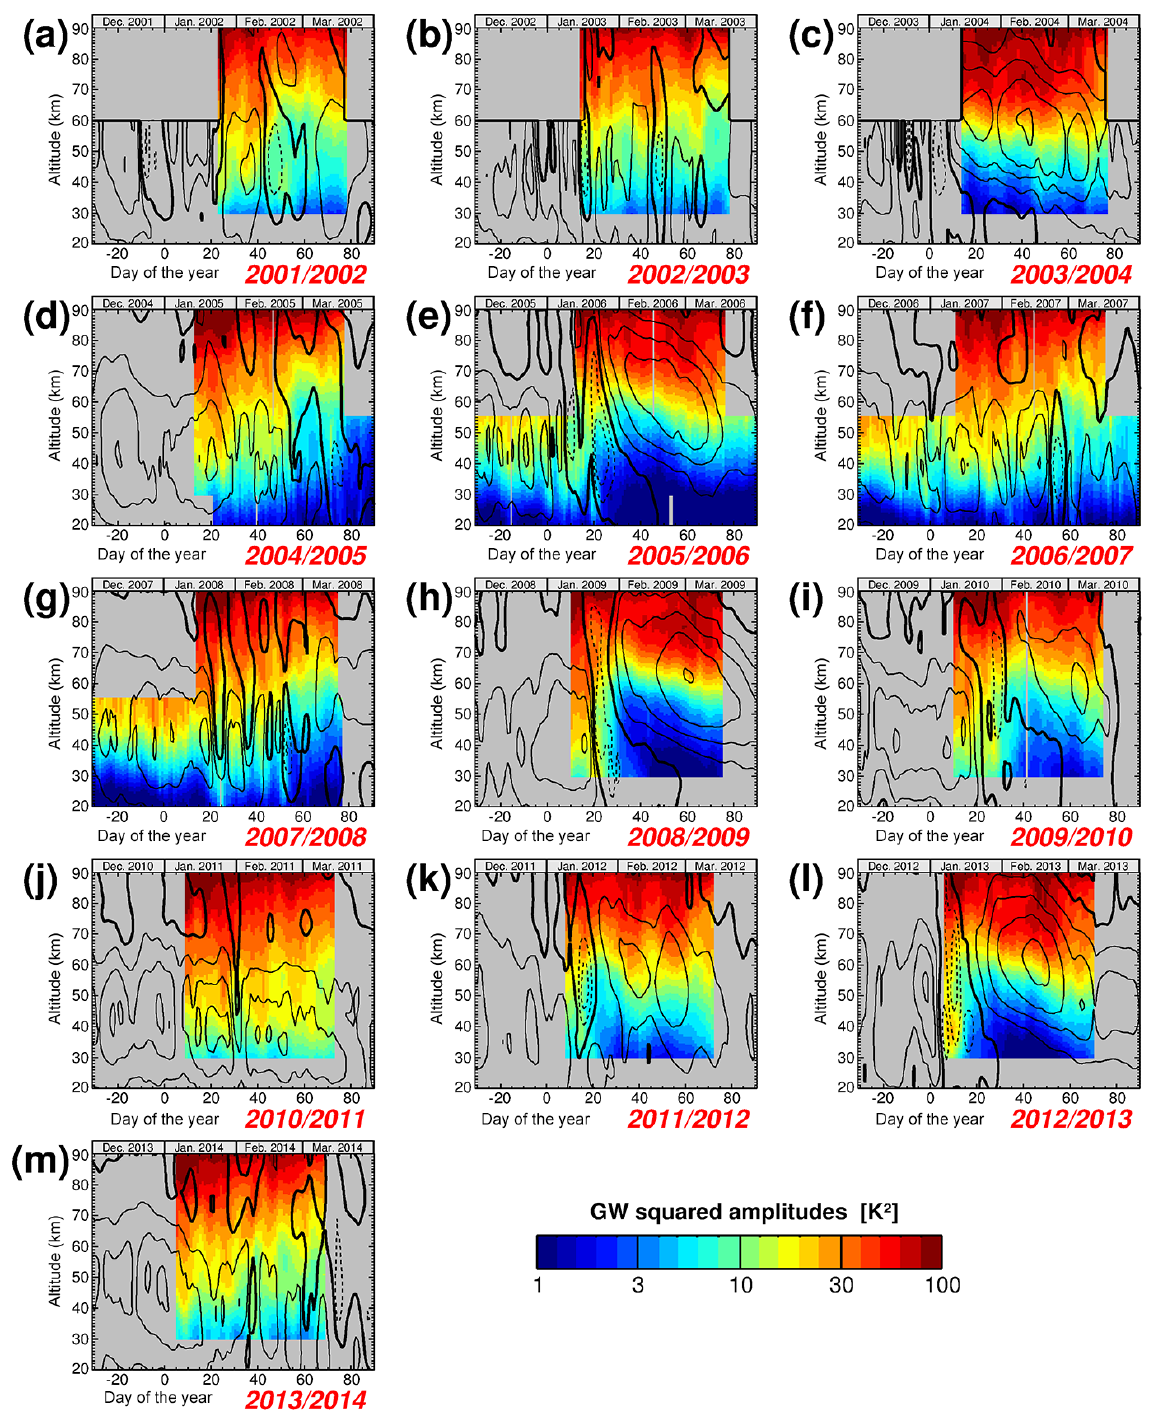
Figure 3. Altitude–time cross-sections of a combination of 1-day zonal average HIRDLS and 3-day zonal average SABER gravity wave squared amplitudes in the latitude band 60–80 ◦ N during the winters 2001/2002–2013/2014, derived in 10km vertical windows. Time step is 1day for both HIRDLS and SABER. The time scale on the x axis is given in “days of the year” (doy) with 1 January 00:00UT as doy = 0. Squared amplitudes are given in K 2 on a logarithmic color scale. Like in Fig. 1, overplotted contour lines indicate zonal average zonal winds at 60–80 ◦ N in steps of 20ms − 1